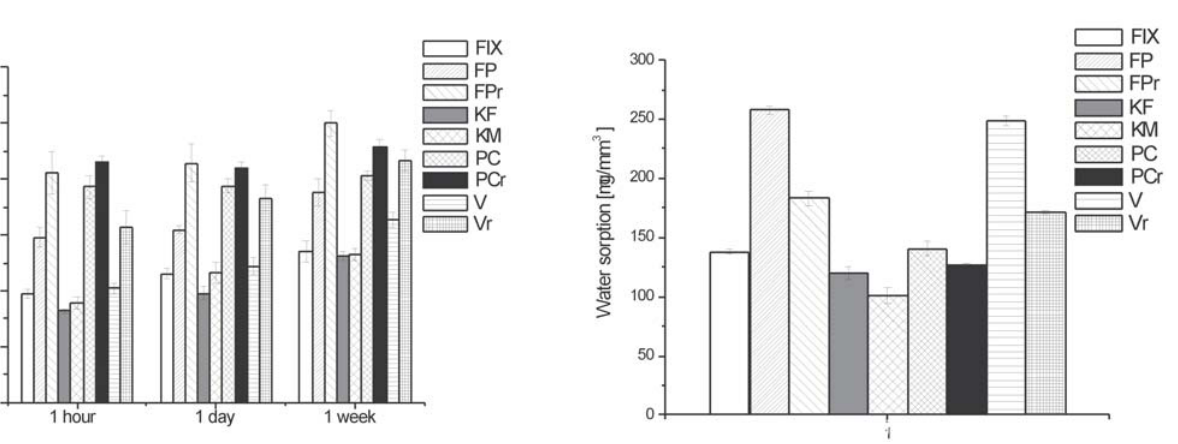
FIGURE 1 - Diametral tensile strength of the studied glass- ionomer cements